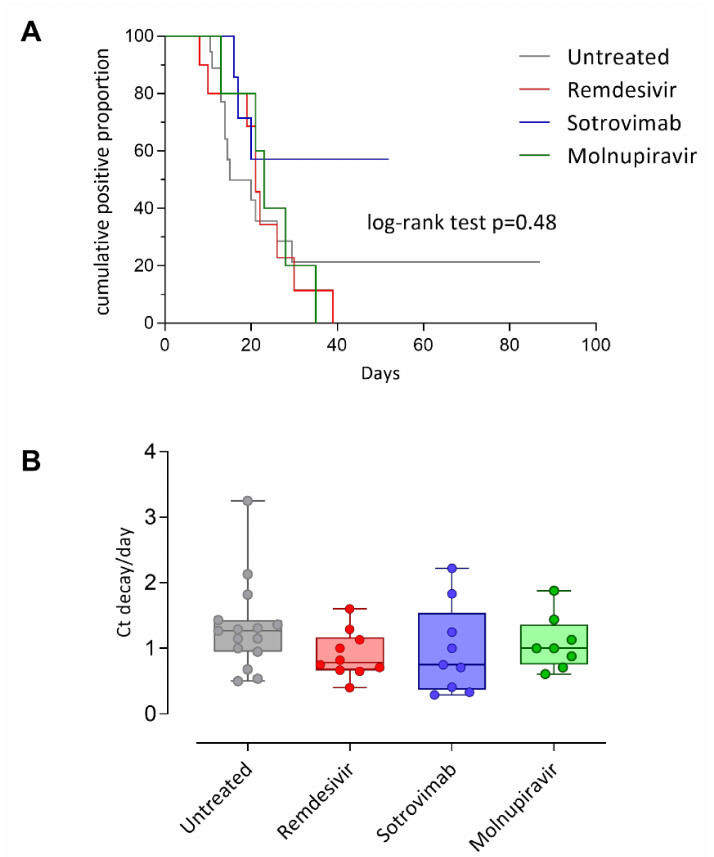
Figure 3. Kaplan–Meier curves of viral shedding duration in untreated and treated patients ( A ). SARS-CoV-2 RNA load clearance in different patients’ categories ( B